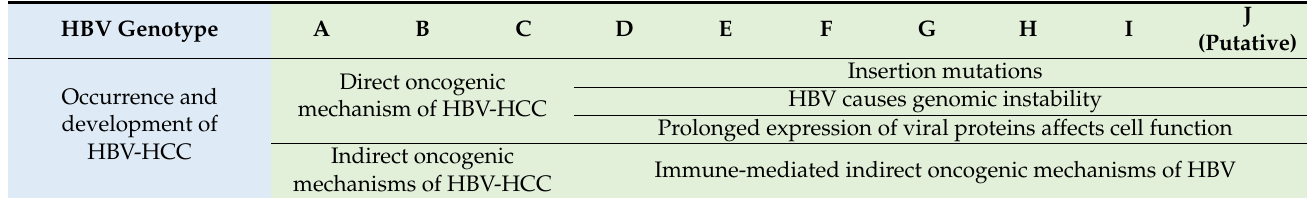
Table 1. HBV genotypes and the oncogenic mechanisms of